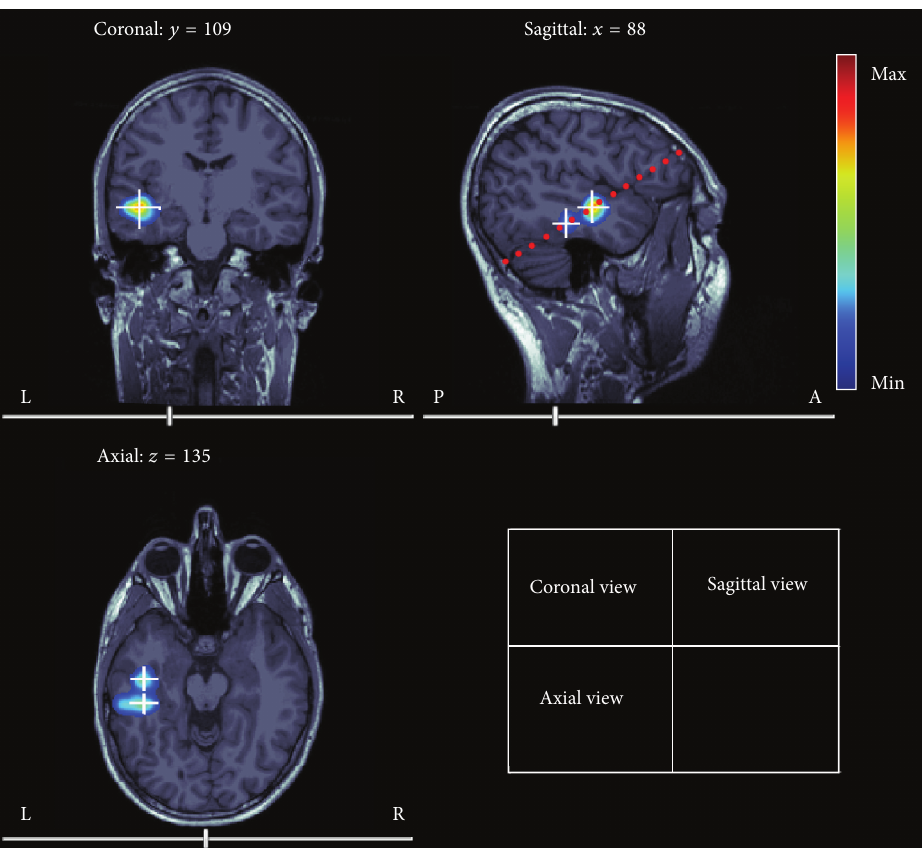
Figure 2: True source locations overlaid on T1 anatomical images. Two closely spaced simulated sources (indicated by white crosses) are located at ( − 5, 45, 40)mm and (5, 45, 40) mm, respectively. PW-INN-based source imaging result (obtained in the condition: real MEG noise; SNR = 18; 𝑟 2 = 0) was also shown as color-coded spatial patterns, where the color denotes the imaging index from (9). The dotted red line in the sagittal view indicates the plane of 𝑧 = 40